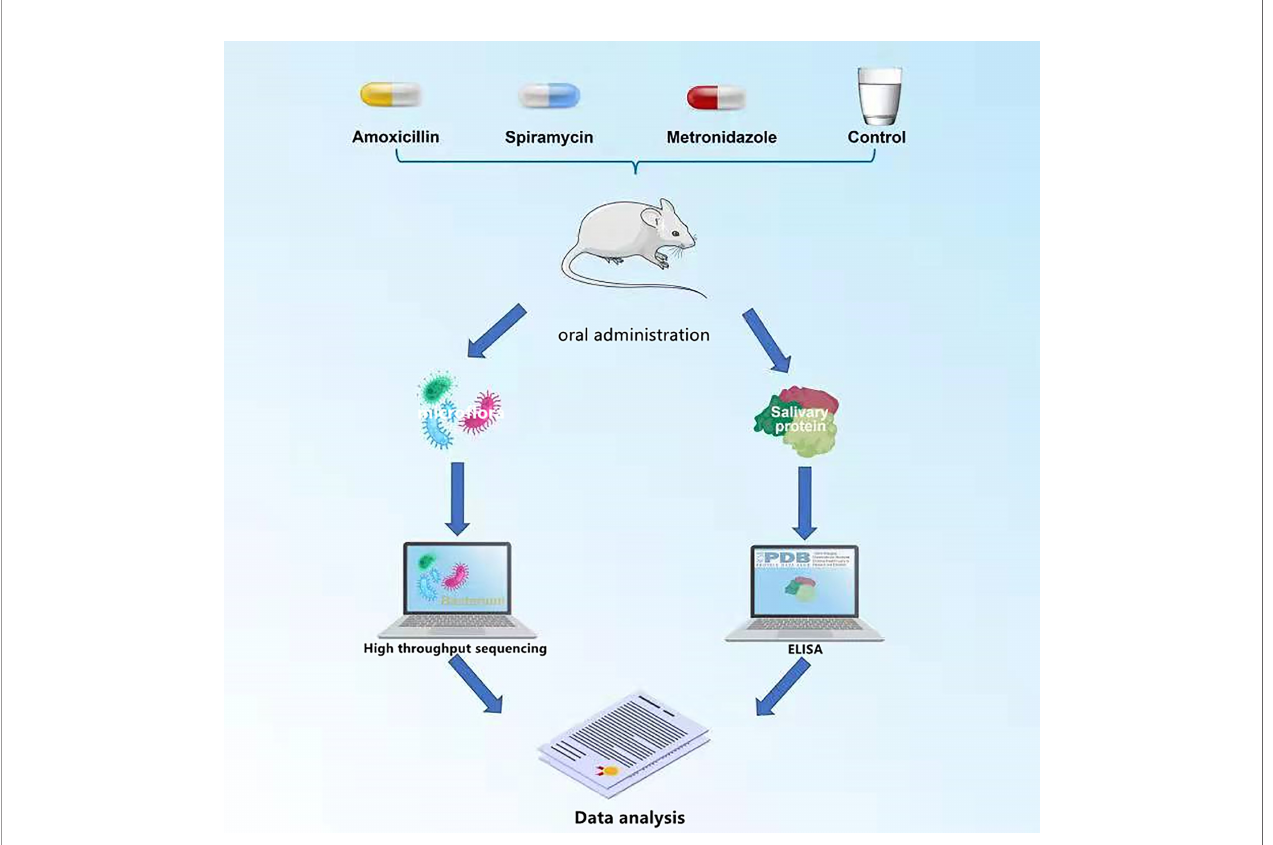
FIGURE 1 | Research mind